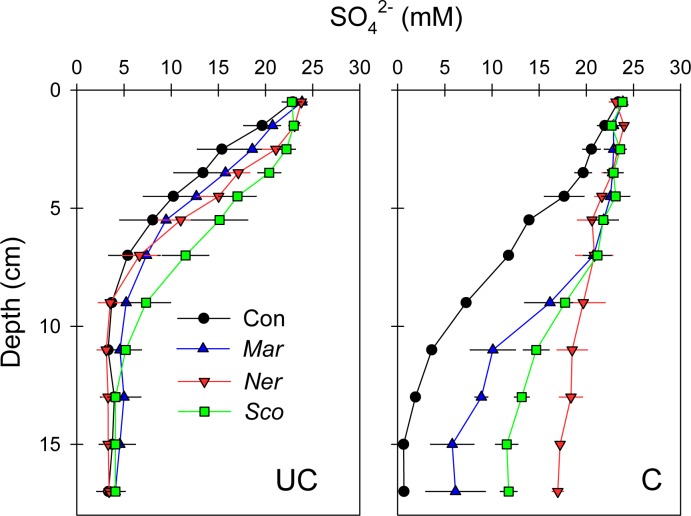
Depth profiles of porewater SO42- in uncultivated soil (UC) and cultivated soil (C) flooded with seawater, without (Con) or with polychaetes added (Mar: Marenzelleria viridis, Ner: Nereis diversicolor and Sco: Scoloplos armiger).Error bars indicate standard error (n = 3).